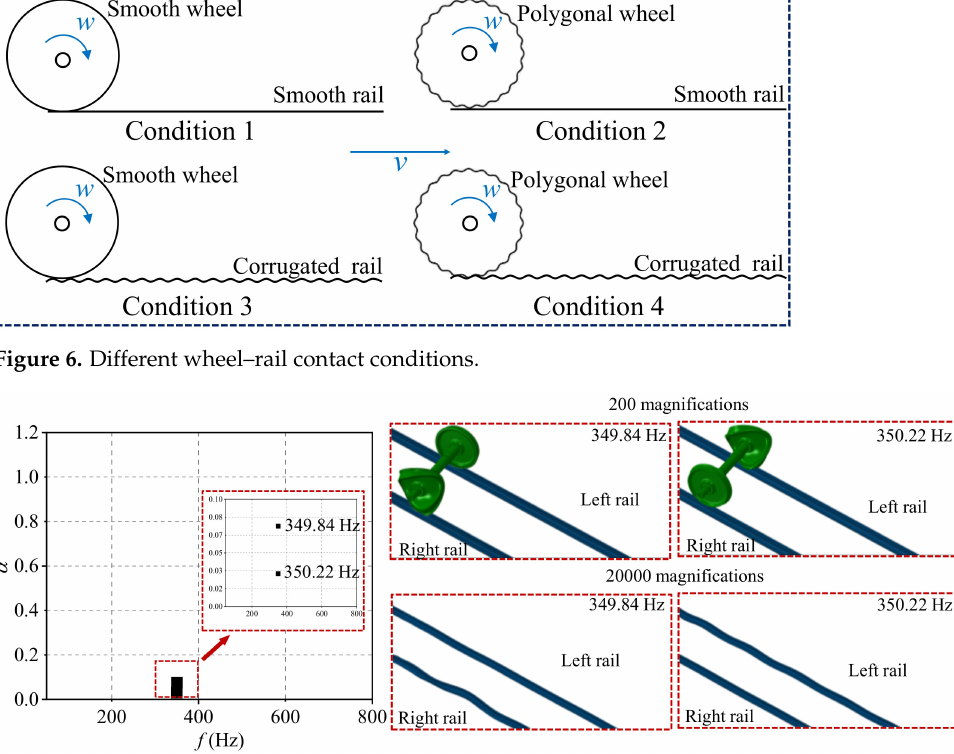
Figure 7. Distribution of real parts of eigenvalues and modal situations of the smooth wheel–smooth rail